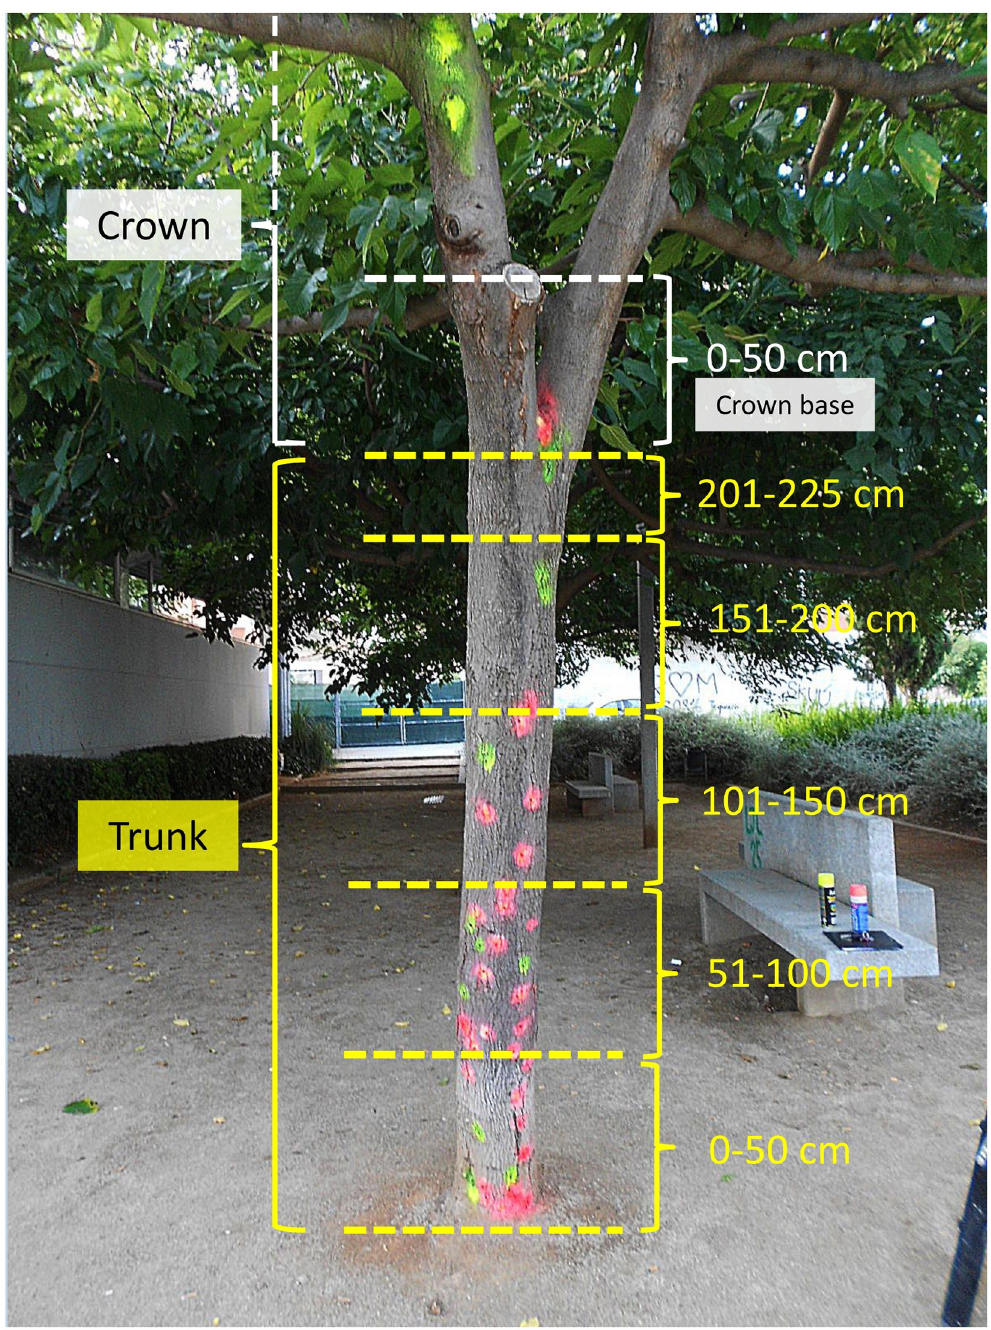
Fig 6. A mulberry tree showing the 50 cm-height bands established for positioning indicators of infestation. In this tree, the top band on the trunk measures only 25 cm before reaching the crown base from the fourth 50 cm-trunk band. Coloured spots signal emergence holes. (Photo G.